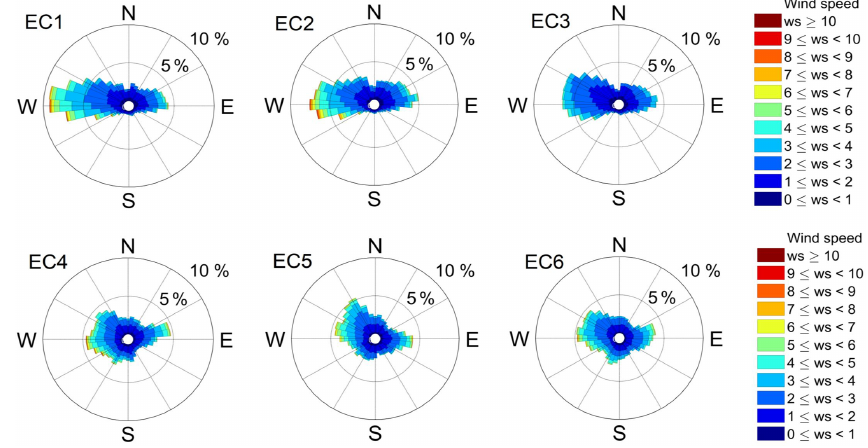
Figure 7. Distribution of wind direction and wind speed (ms − 1 ) from 2010 to 2017 in Kraichgau (EC1–EC3) and Swabian Jura